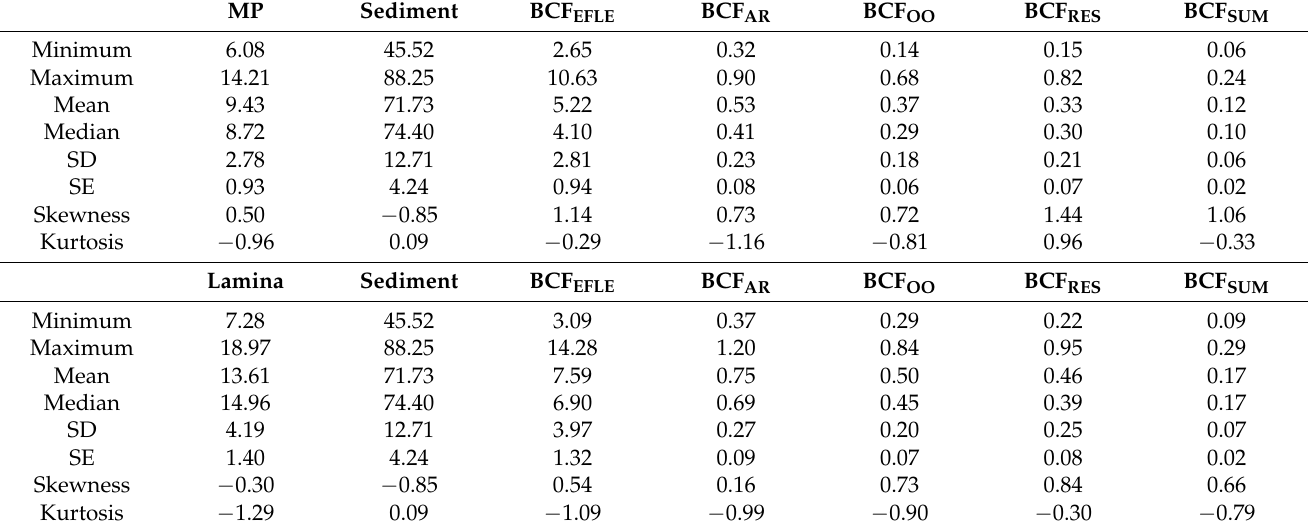
Table 1. Overall statistics of Zn concentrations (mg/kg dry weight) in the midrib plus petiole (MP) and lamina of Rhizophora apiculata , with their habitat geochemical fractions of sediments and their bioconcentration factors (BCF) values, collected from nine sampling sites in the mangrove areas of Sepang and Lukut. N =